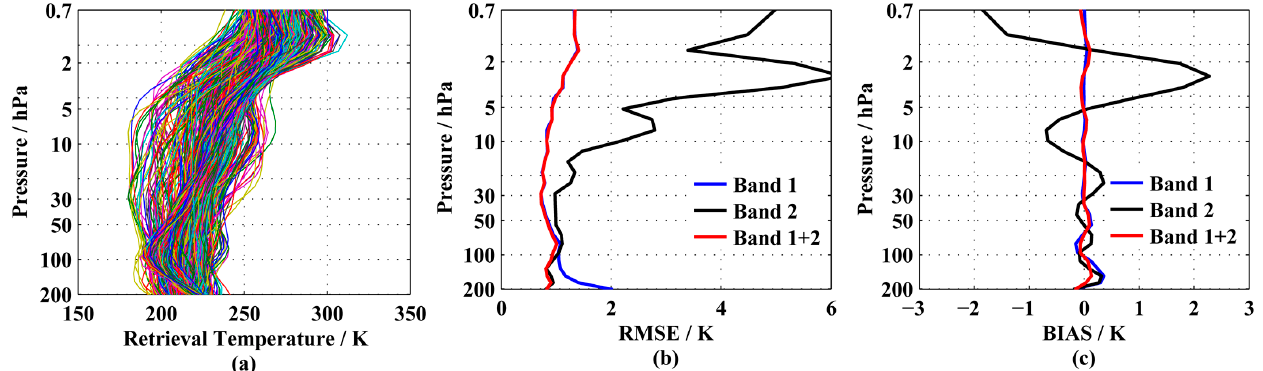
Figure 15. The separate and joint retrieval accuracy with the two narrow bands. ( a ) All the retrieval temperature pro fi les. ( b ) RMSE of temperature. ( c ) BIAS of temperature.